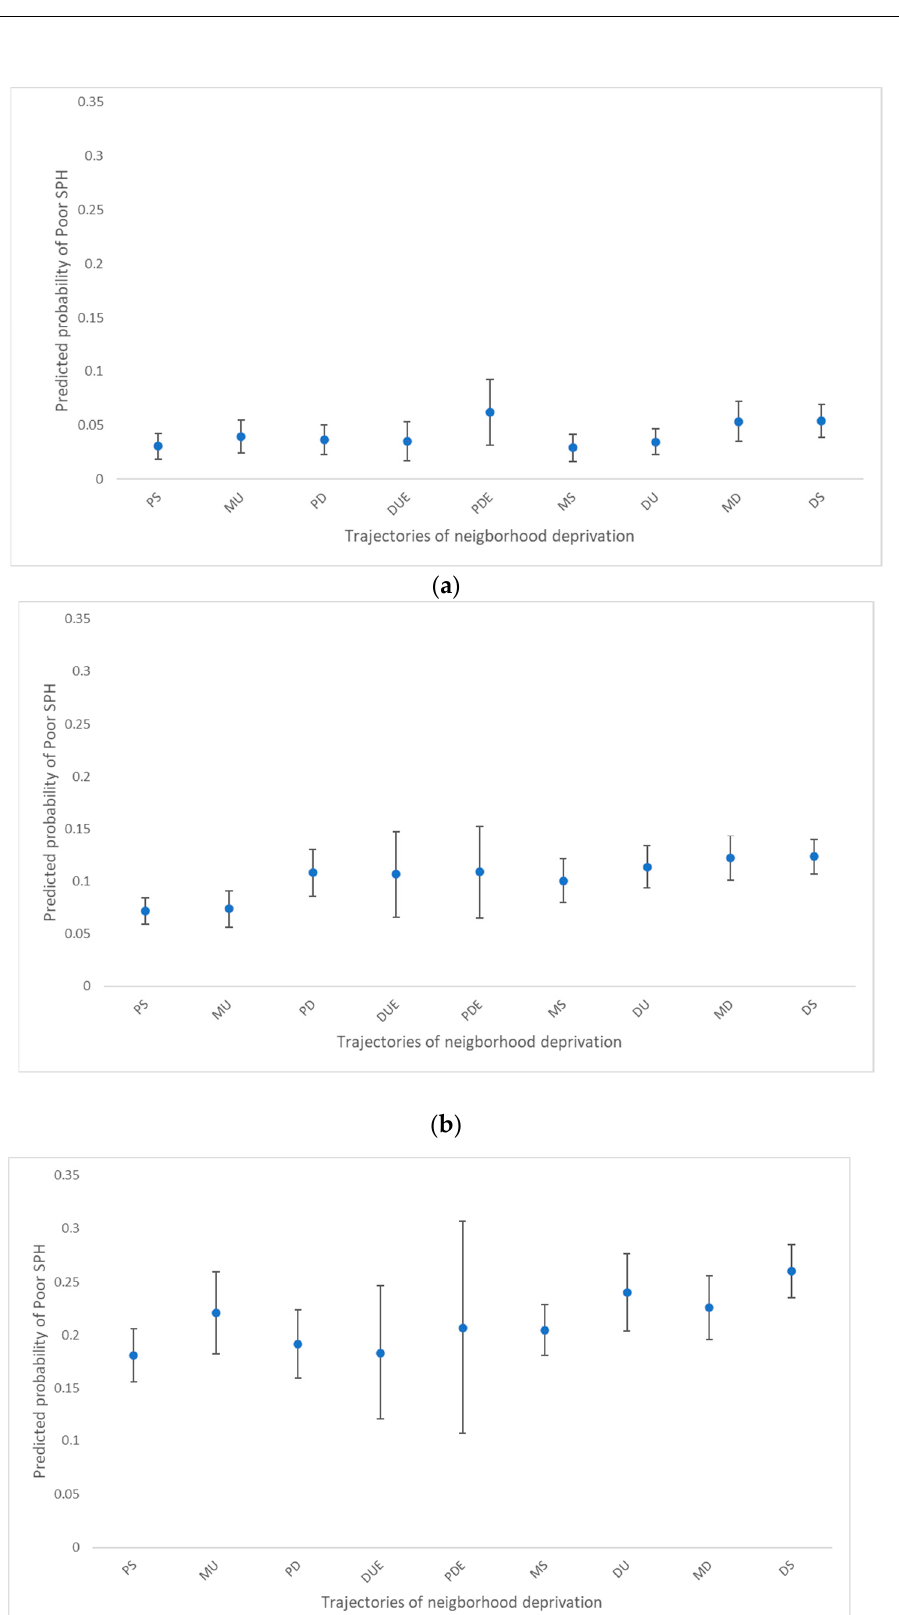
Figure 3. Predicted probability of poor SPH over neighbourhood deprivation trajectories (NDT) by age group ( a ) under 40 years, ( b ) 40–64 years, ( c ) over 65 years. Notes: predicted probability of SPH is shown on the y -axis and deprivation trajectories group is shown on the x -axis. Error bars on graphs indicate 95% confidence intervals. Privileged Stable (PS), Medium Upward (MU), Privileged Downward (PD), Deprived Upward Extreme (DUE), Privileged Downward Extreme (PDE), Me- dium Stable (MS), Deprived Upward (DU), Medium Downward (MD), Deprived Stable (DS).